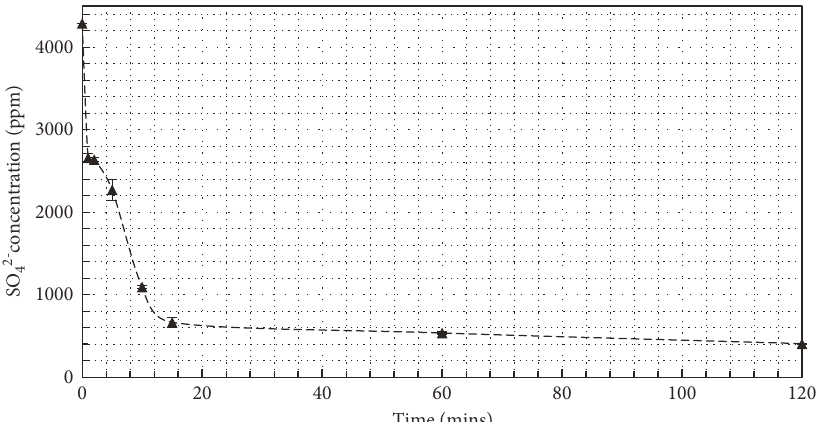
Figure 2: Sulfate concentration in seawater after adding different concentrations of NaAlO sulfate concentration is less than 10%.